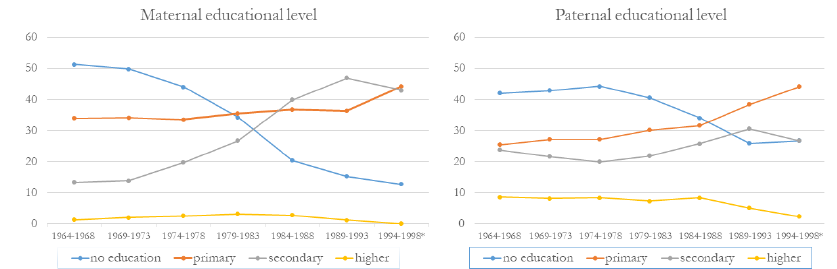
Figure 1 – Maternal and paternal educational level. Percentage values by mother’s cohort (* the 1994-1998 cohort includes 86 cases). Source: Bangladesh Demographic and Health Survey